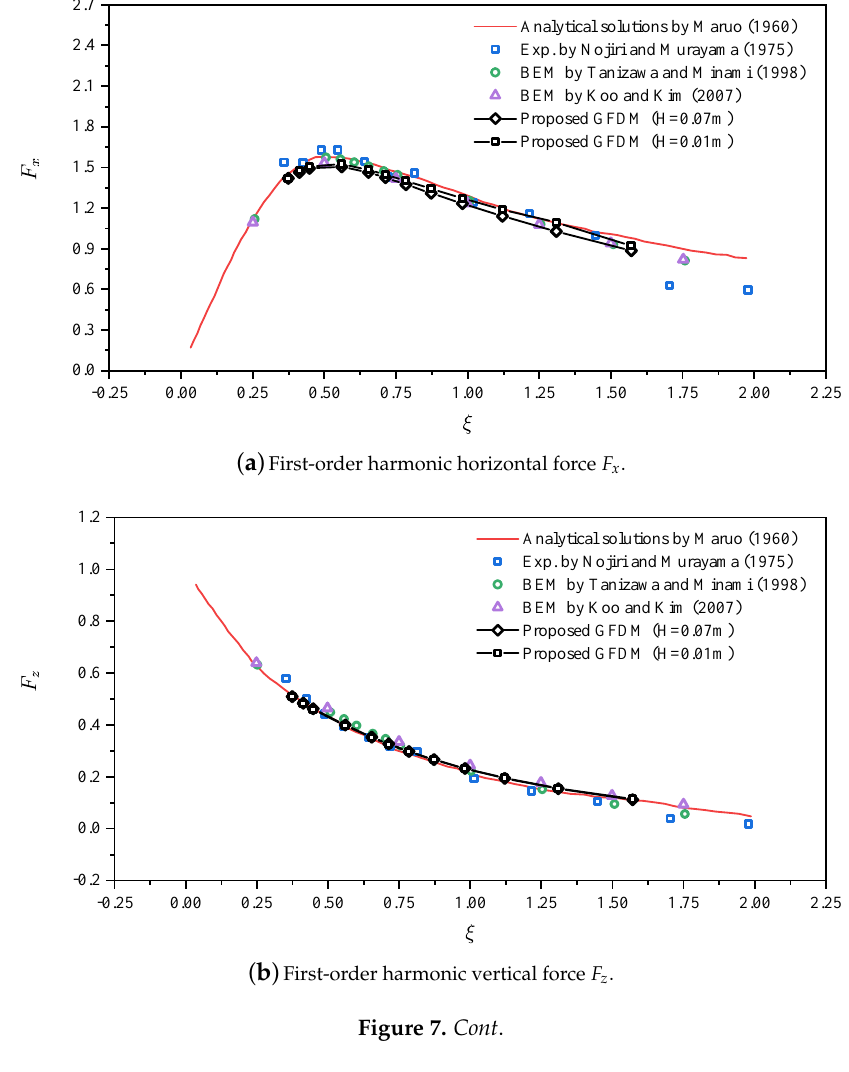
( b ) First-order harmonic vertical force F z . Figure 7. Cont